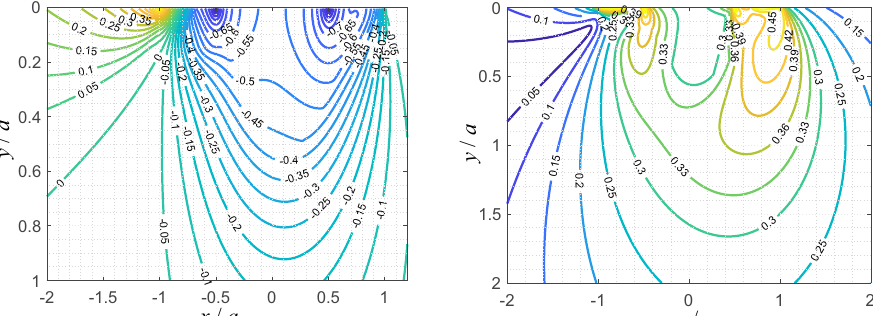
Figure 3. Contour line diagram of the largest principal stress, normalized for the average contact pressure P / ( 2 a ) ( left ), and the maximum shear stress, normalized for the average contact pressure ( right ), in the tangential contact with a truncated cylinder, as a function of x / a and y / a , for b = 0.5 a , c = 0.7 a , µ = 0.5 and ν = 0.3.